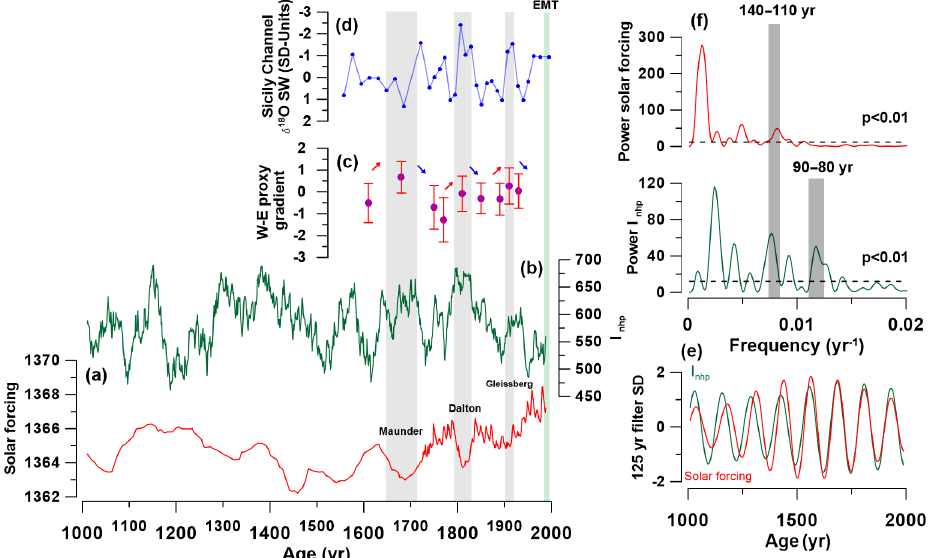
Figure 4. Past EA/WR-like pattern variability and its correspondence with climate proxies. (a) Solar forcing (Crowley, 2000). (b) I nhp index. (c) Western–eastern basin SST gradient. (d) Sicily channel δ 18 O sea water in standard units (Incarbona et al., 2016). (e) Standardized Gaussian filter centered at 0.008yr − 1 (i.e., 125 years) with 0.001yr − 1 bandwidth (i.e., 110–140 years) of I nhp index and solar forcing. (f) Power spectra of solar forcing and I nhp index based on Lomb periodogram algorithm using the PAST 3.12 software package (Hammer et al., 2001). Dashed lines represent white noise ( p< 0 . 01). Grey bars at figures (a) – (d) represent periods of solar irradiance lows. Green bar in panels (a) – (d) refer to the last EMT